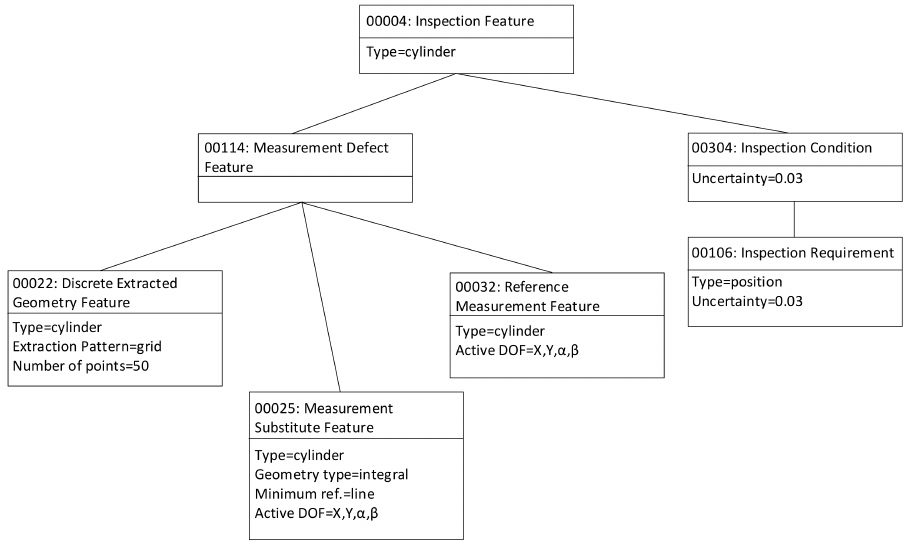
Figure 11. Some object instances and relations of the case